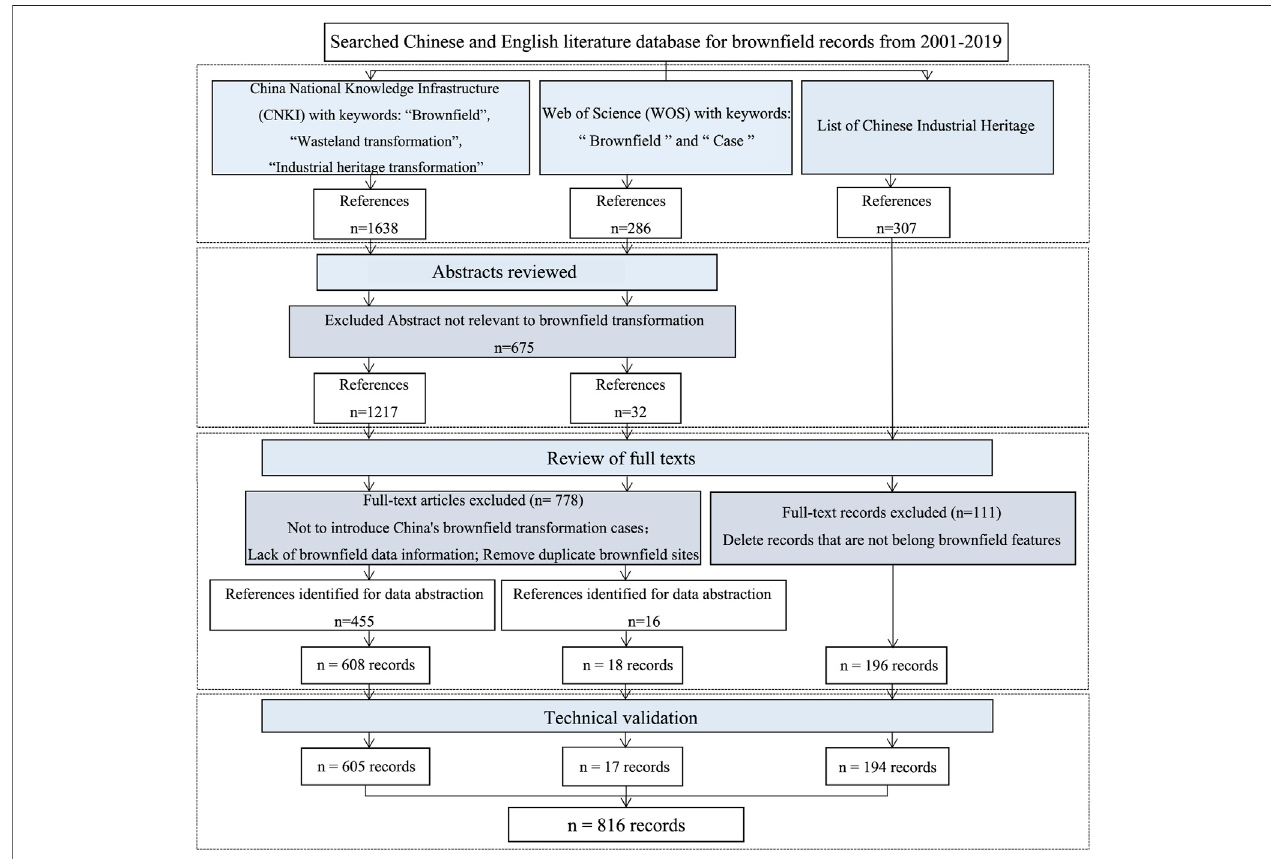
FIGURE 1 | Schematic overview of the literature search procedures and